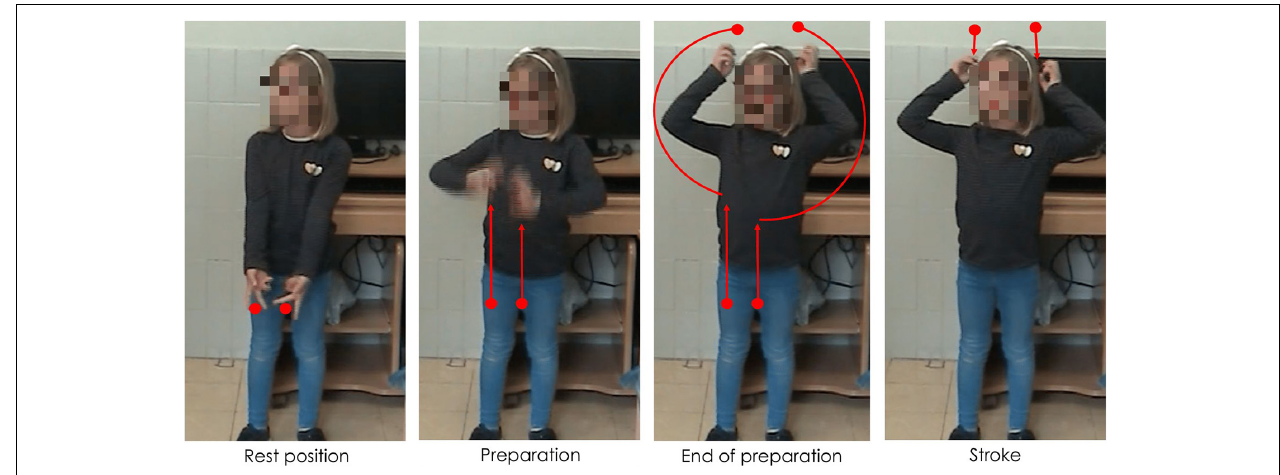
FIGURE 5 | Caption of a referential iconic gesture while saying “la part de DALT” (“the UPPER part”). Capitalization indicates the word accompanied by a gesture.